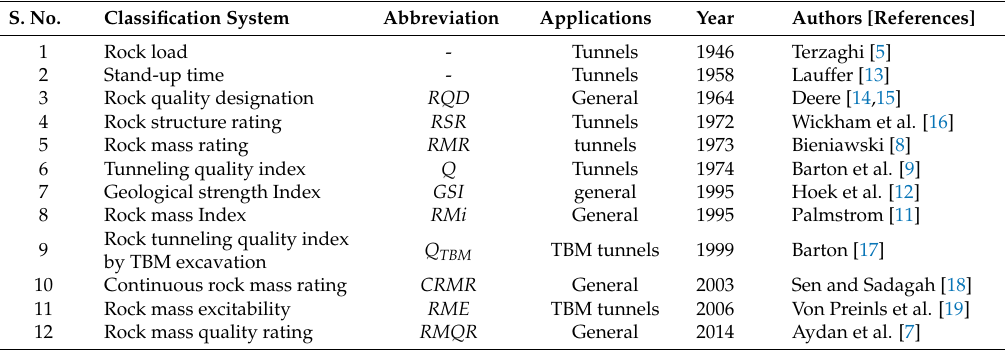
Table 1. The rock mass classification systems used in the design of